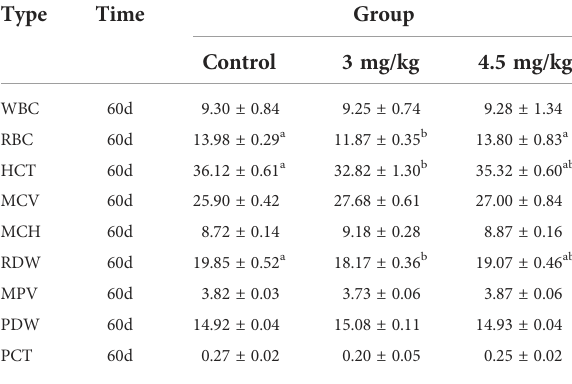
TABLE 3 Effects of melatonin implantation on blood routine indexes of the sheep.